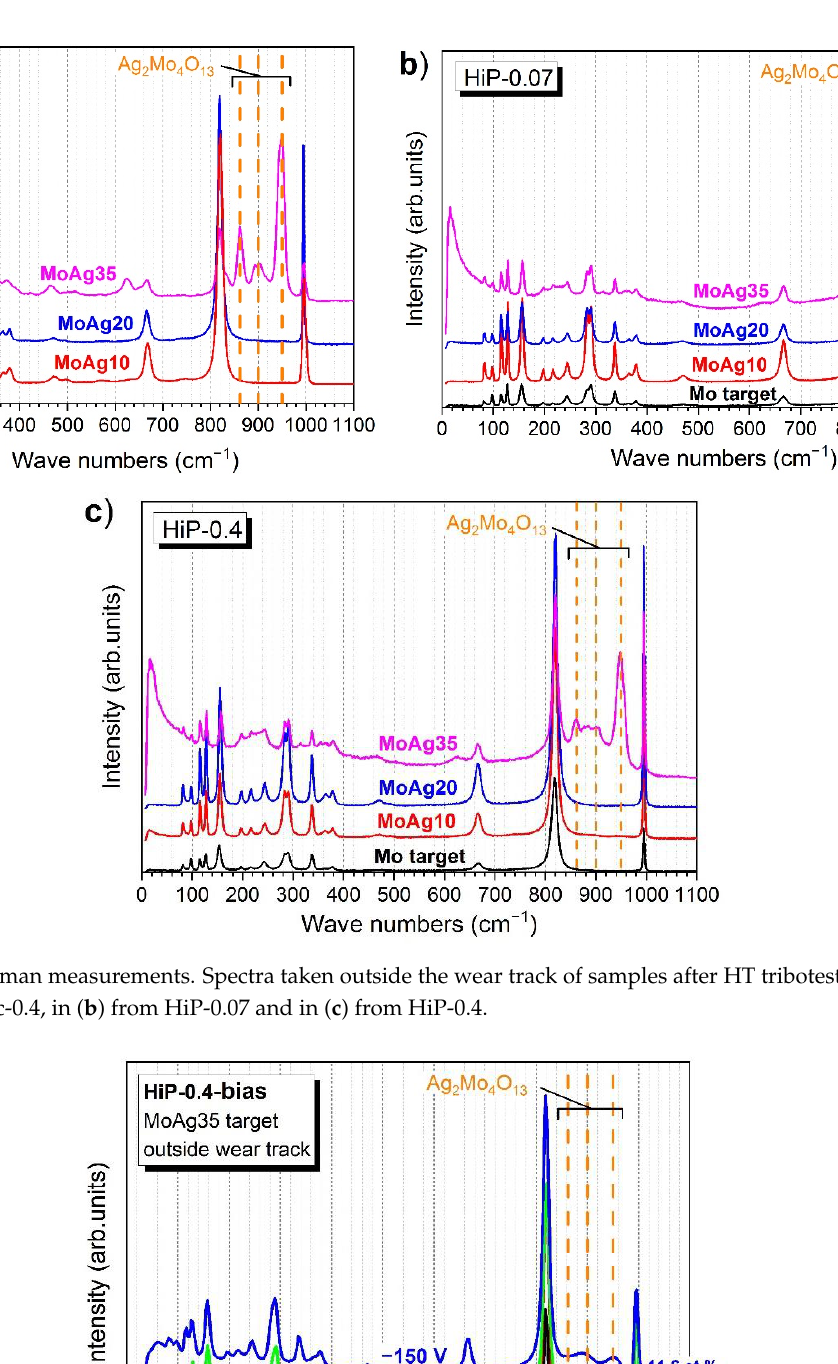
Table 4. Measured peaks of MoO 3 phase in the Raman spectra of Figures 17 and 18. The intensities are given in brackets as w = weak, m = medium, s = strong and vs = very strong.